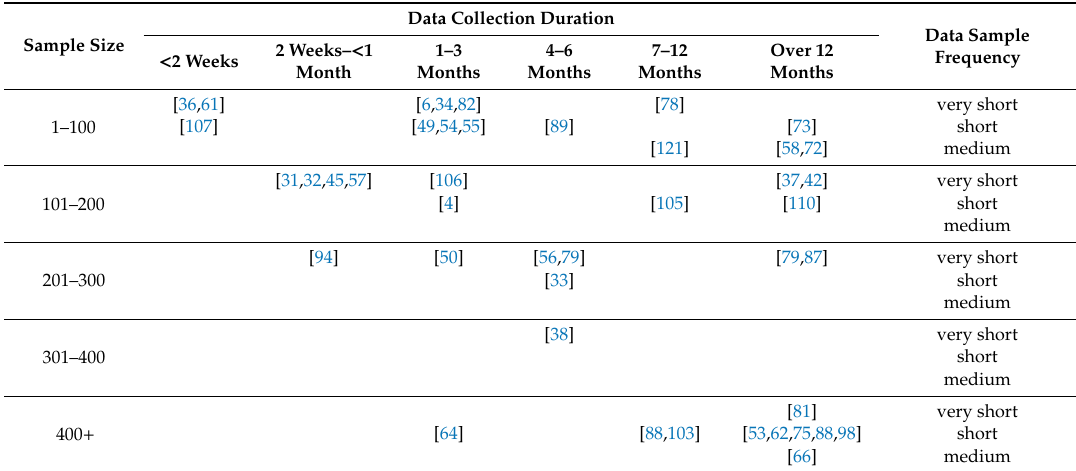
Table 7. Summary of the studies based on sample size, data collection duration, and data frequency. Sample